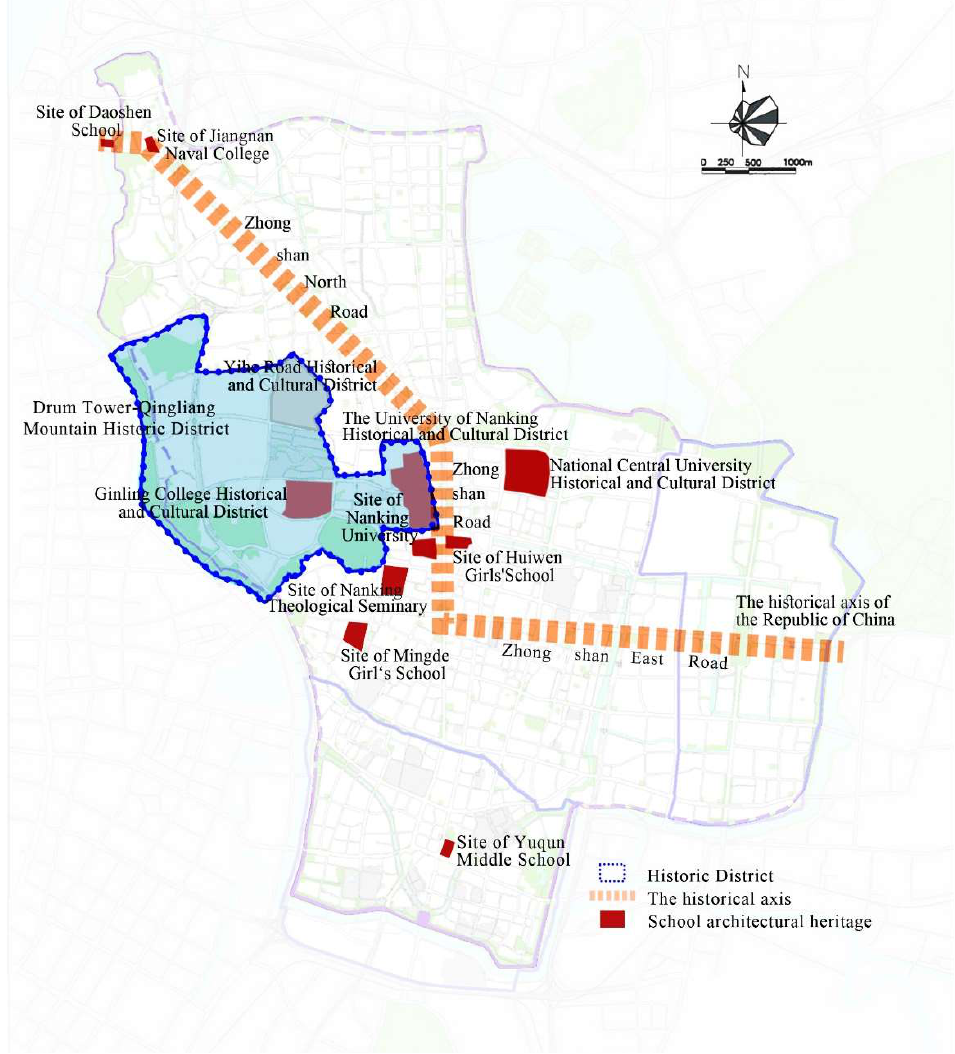
Figure 16. Conservation Plan of Historical City of Nanjing (2010–2020) (based on the Nanjing Famous Historical and Cultural City Conservation Plan (2010–2020) by Nanjing Bureau of Planning and Natural Resources).